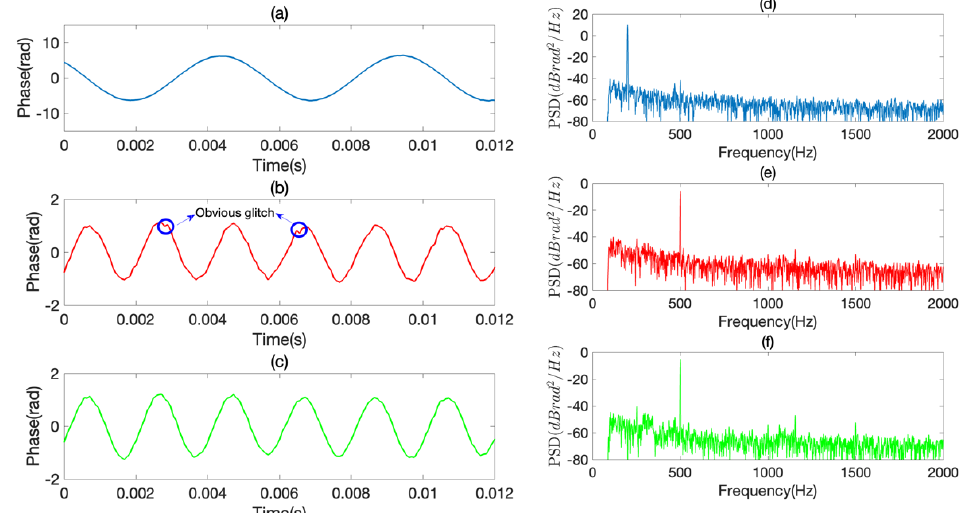
Figure 6. Phase at the positions of ( a ) PZT and ( b ) handmade microphone before multi-channel averaging. Phase at the position of handmade microphone after multi-channel averaging ( c ). PSD of phase at the positions of ( d ) PZT, ( e ) handmade microphone before multi-channel averaging and ( f ) handmade microphone after multi-channel averaging.